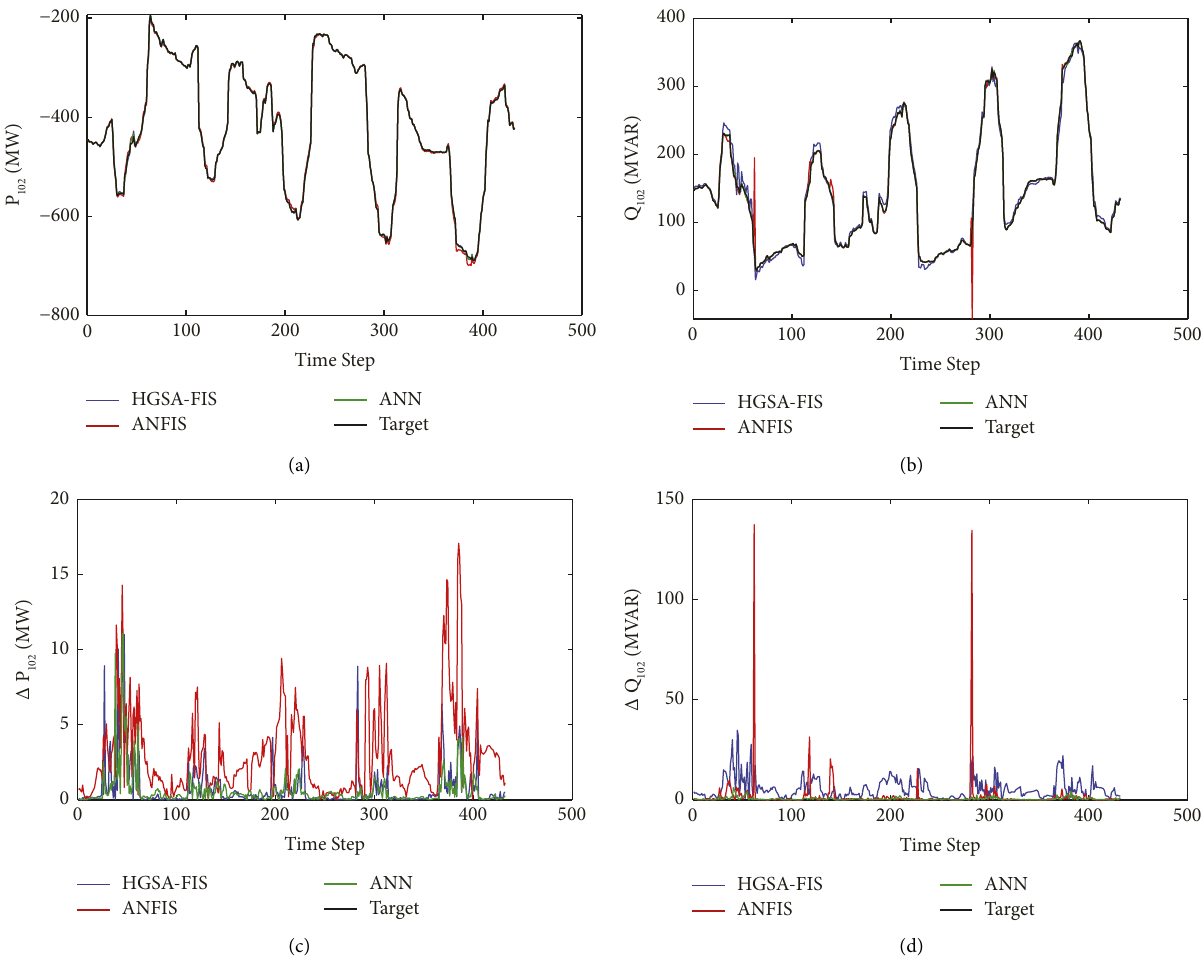
Figure 14: Comparison of prediction accuracy of HGSA-FIS, ANFIS, and ANN models in predicting tie-line L102 power flows: (a) P Q | , and (d) APE | Δ Q , (c) APE | Δ P 102 102